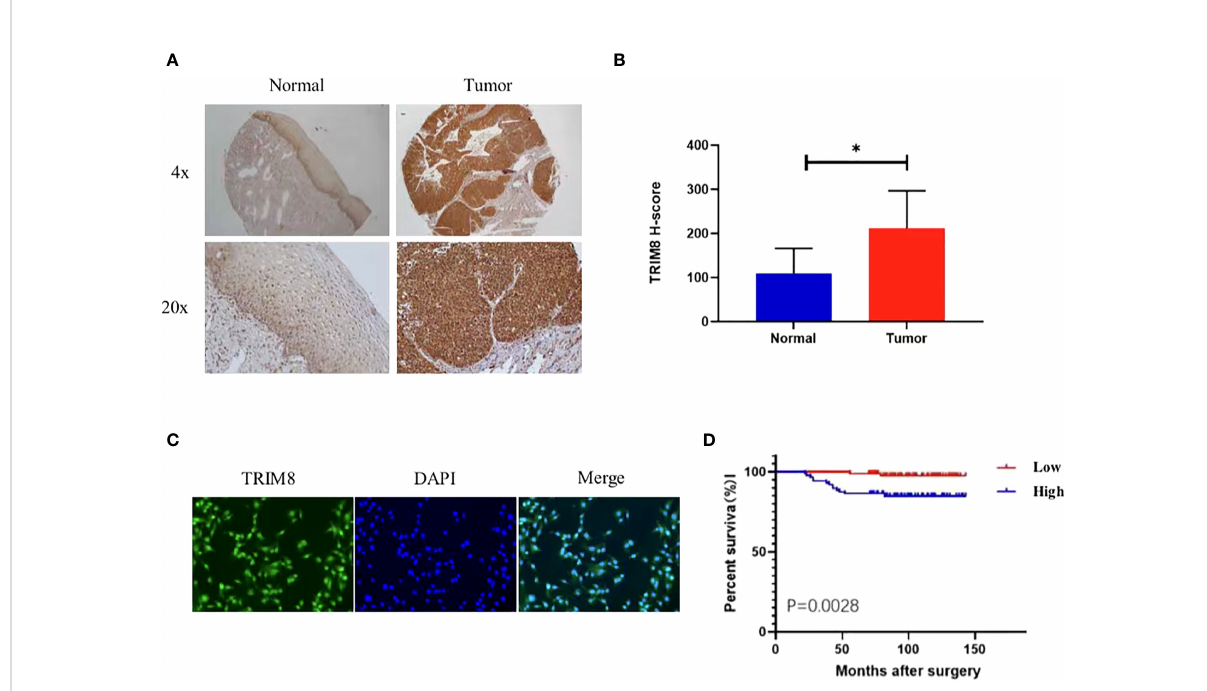
FIGURE 6 Expression and prognosis of TRIM8 in cervical cancer. (A) The IHC showed that TRIM8 protein is highly expressed in tumor tissues. (B) Statistical results of IHC score of TRIM8. *p<0.05. (C) Distribution of TRIM8 in cervical cancer cells. (D) Kaplan Meier curve analysis of patients with high and low expression levels of TRIM8.